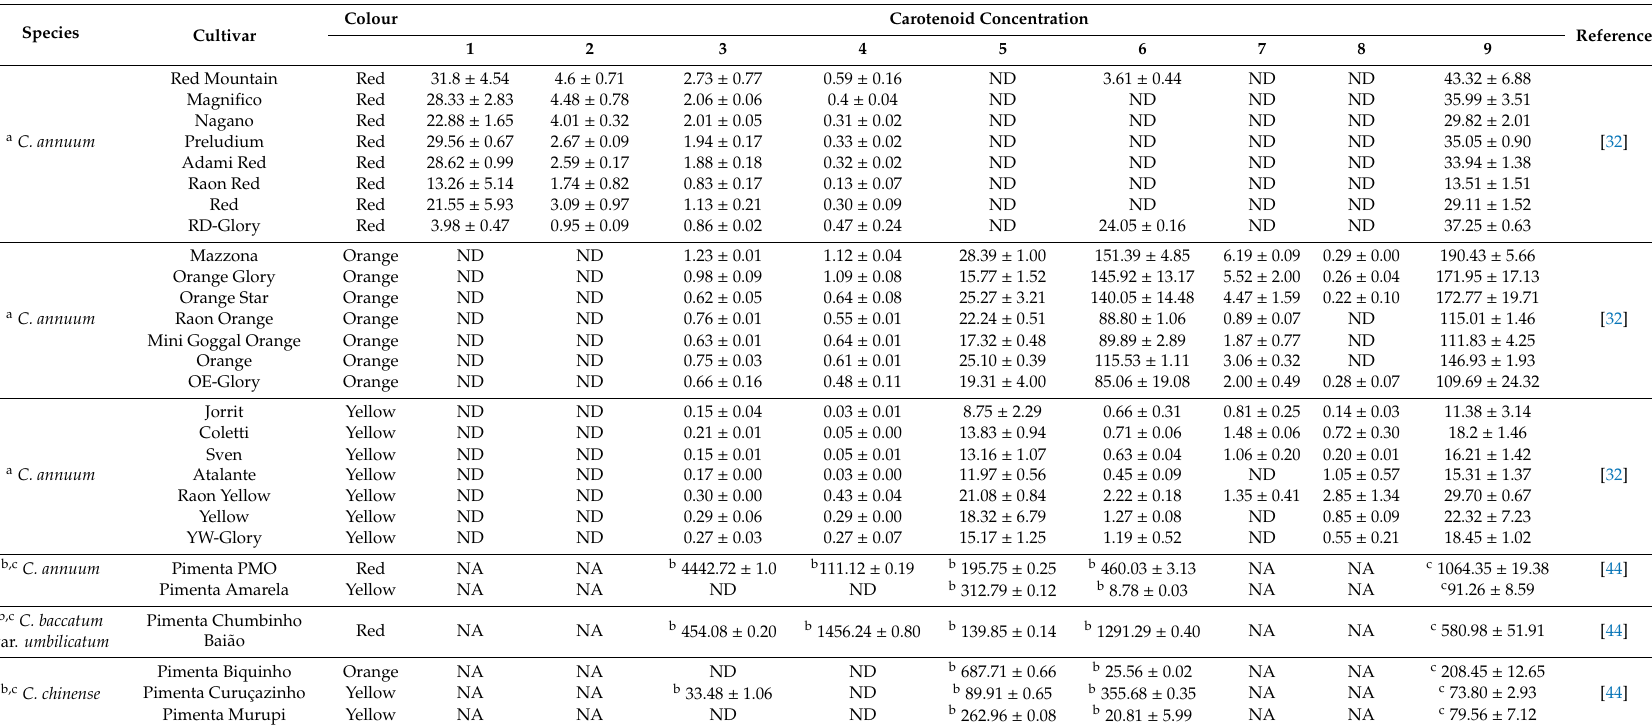
Table 1. Variable levels of main carotenoids in selected collections of sweet and hot